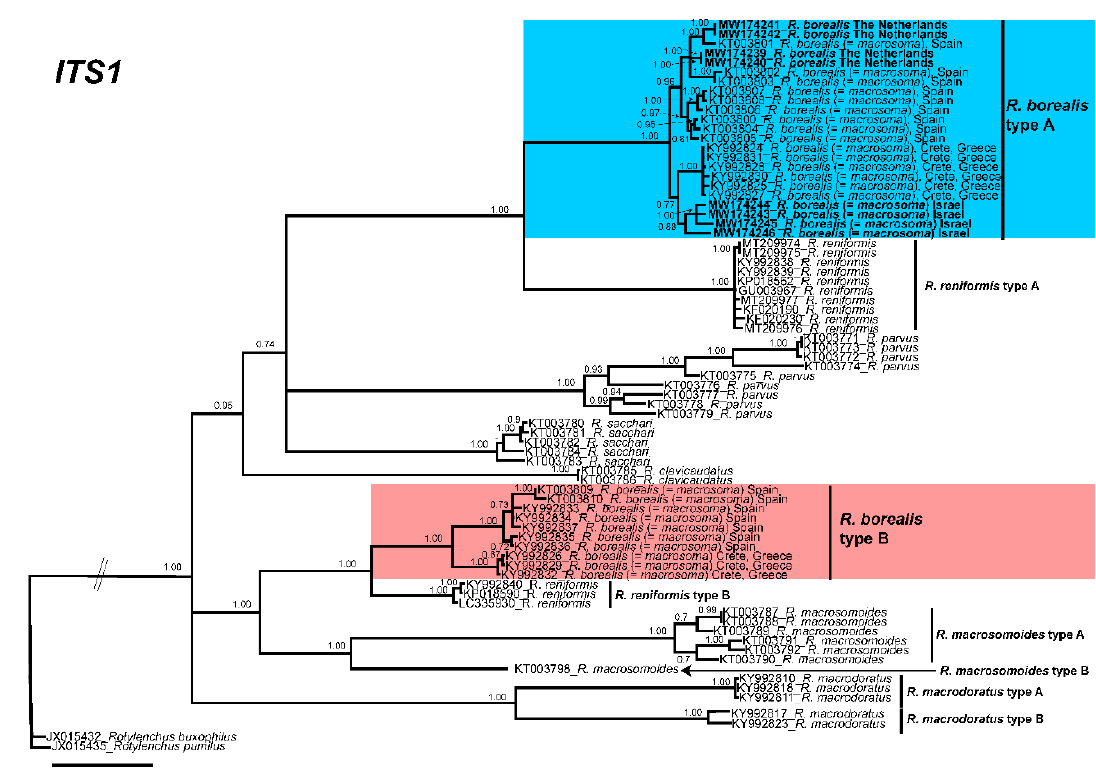
Figure 4. Phylogenetic relationships within the genus Rotylenchulus . Bayesian 50% majority rule consensus tree as inferred from ITS1 rRNA sequence alignment under the general time-reversible model of sequence evolution with correction for invariable sites and a gamma-shaped distribution (GTR + I + G). Posterior probabilities of more than 0.70 are given for appropriate clades. Newly obtained sequences in this study are shown in bold. Scale bar = expected changes per site.